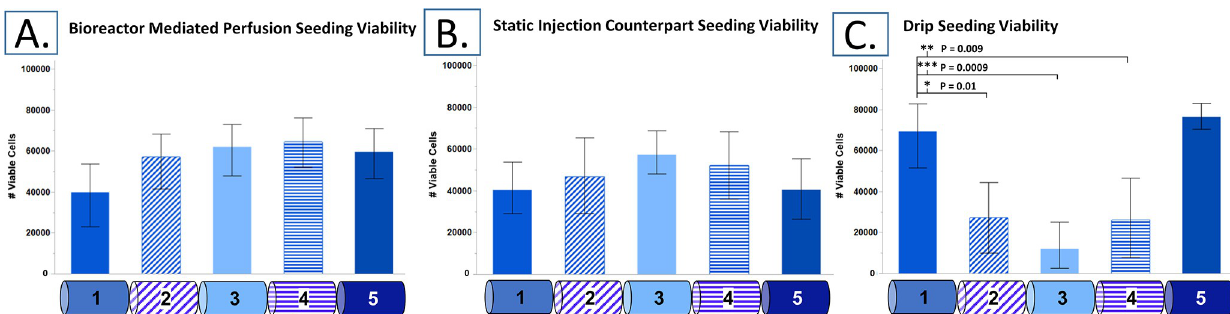
Fig 3. AlamarBlue viability assay results. Section average viable cell numbers for (A) perfusion bioreactor seeding, (B) static counterpart seeding, and (C) drip seeding. (n = 4; mean with 95% confidence intervals).